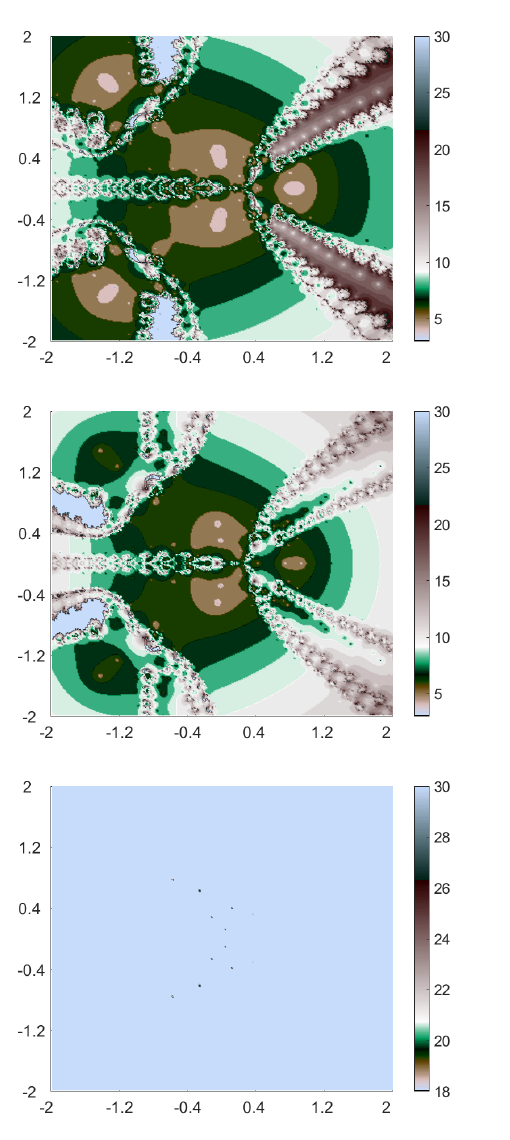
Figure 3. Visualisation of effects of s-convexity on polynomiographs for p ( z ) = z 5 + 2 z 4 + 2 z 3 − 3 z 2 − 1: s = 1 ( Top Left ); s = 0.95 ( Top Right ); s = 0.8 ( Middle Left ); s = 0.5 ( Middle Right ); s = 0.25 ( Bottom Left ), and s = 0.05 ( Bottom Right